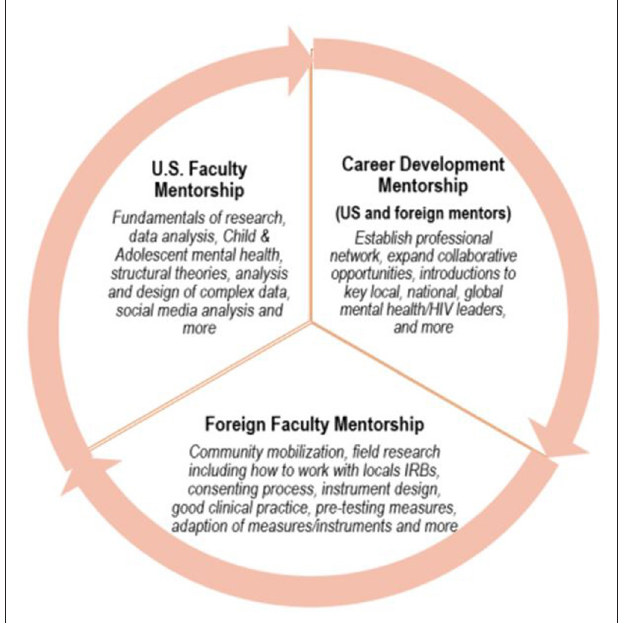
FIGURE 1 | Mentorship